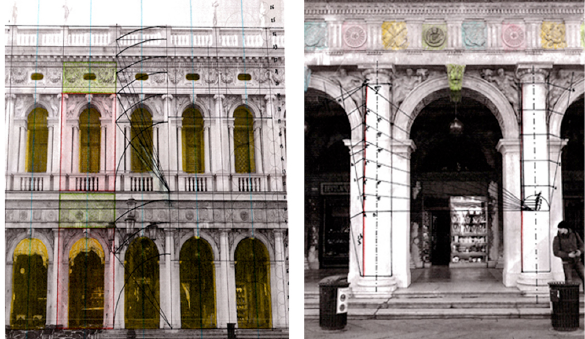
Figure 5 - Photographic survey of the different facades with proportioning schemes based on tilting the diagonal of the square base